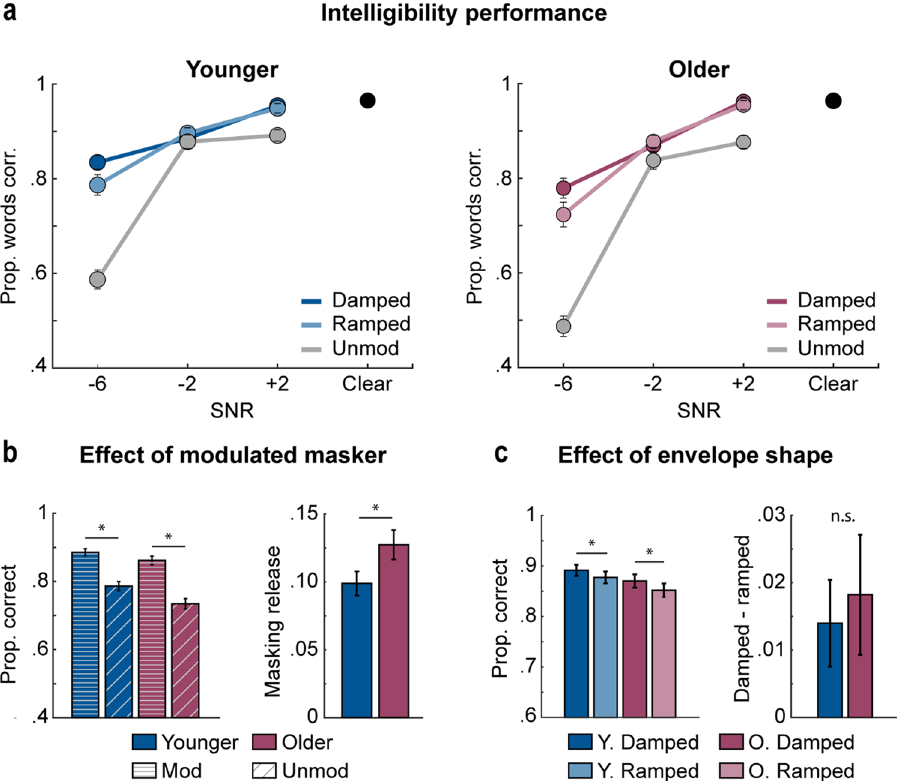
Figure 4. Intelligibility results for Experiment 2. ( a ) Mean proportion of correctly reported words are plotted as a function of SNR (− 6, − 2, + 2 dB, Clear [black dot]) for the different envelope conditions (damped, ramped, unmodulated) and for younger (left) and older adults (right). ( b ) Mean word report (left) is plotted for the different modulation types (modulated, unmodulated) and age groups (younger, older). The difference in performance between modulated and unmodulated maskers (masking release) is plotted for both age groups (right). Plots for modulated maskers reflect the mean across damped and ramped envelope shapes. ( c ) Mean word report (left) is plotted for the different masker envelope shapes (damped, ramped) and age groups (younger, older). The difference in performance between the damped and ramped envelope shapes is plotted for both age groups (right). Error bars reflect the standard error of the mean. *p <